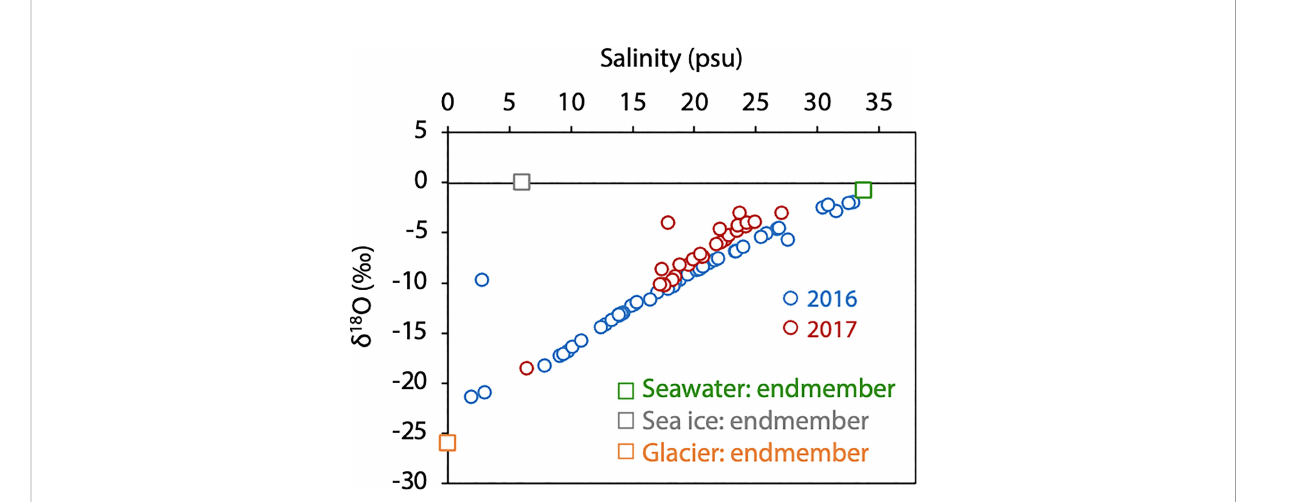
FIGURE 2 Relationship between d 18 O and salinity for surface water and each